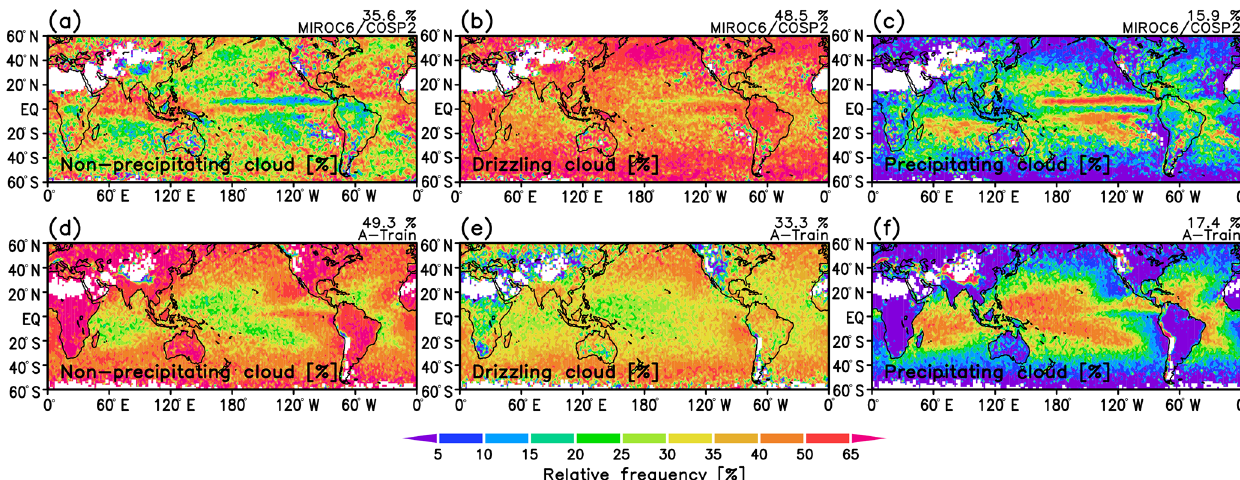
Figure 2. Geographical maps of the fractional occurrence of (a, d) non-precipitating clouds ( Z max < − 15dBZ e ), (b, e) drizzling clouds ( − 15dBZ e < Z max < 0dBZ e ), and (c, f) precipitating clouds (0dBZ e < Z max ) obtained from (a–c) the MIROC6–COSP2 simulation of one full year and (d–f) the A-Train satellite observations for the period June 2006–April 2011. Global means of the occurrence frequency are shown at the top right of each